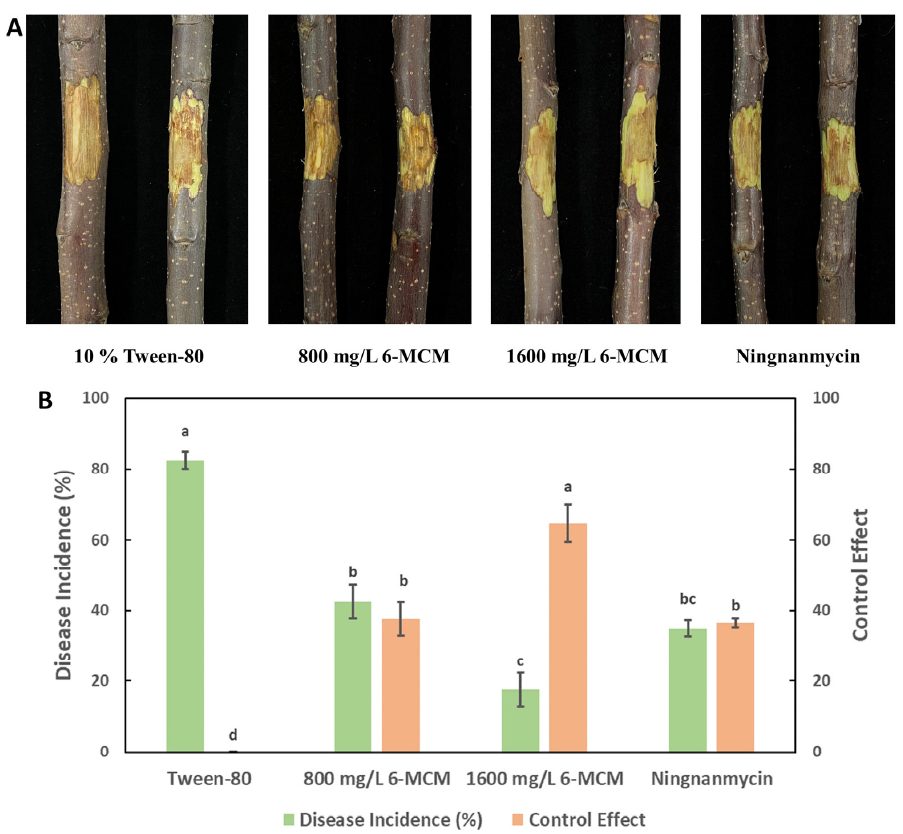
Figure 9. The control effect of 6 ‐ methylcoumarin on Valsa canker of apple tree branches: ( A ) Lesion symptoms and ( B ) Disease incidence and control effect. The bars represent the standard error of the mean (n = 18), and the letters (a–c) represent the difference between 6 ‐ MCM treatment and control of 6 ‐ MCM and 6 ‐ methylcoumarin.